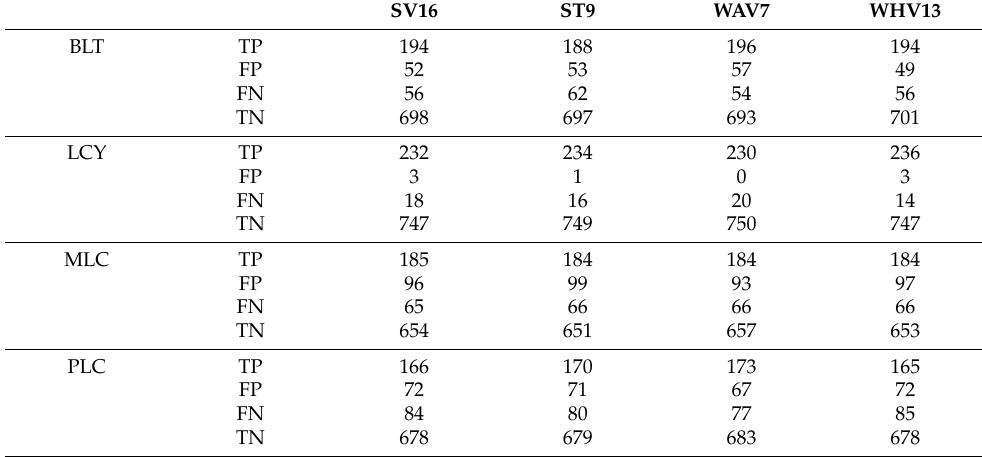
Table 8. Evaluation metrics for the models with the highest accuracy by pruning in each of the four ensemble learning methods. SV16: top16 was used for soft voting, ST9: top9 was used for stacking, WAV7: top7 was used for weighted average voting, WHV13: top13 was used for weighted hard voting. Model